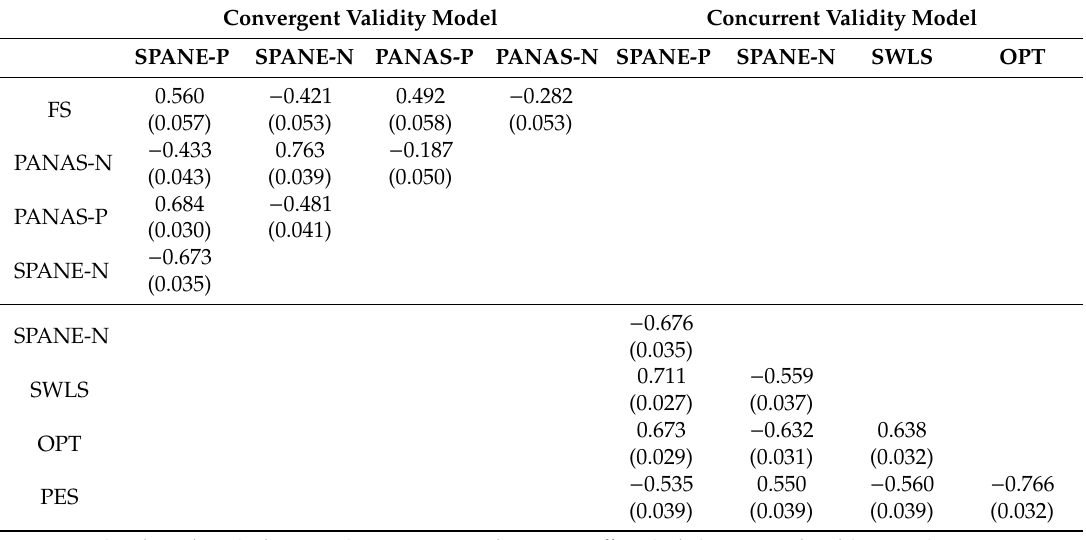
Table 3. Correlation coe ffi cients (standard errors) between SPANE subscales and well-being measures in the convergent and the concurrent validity